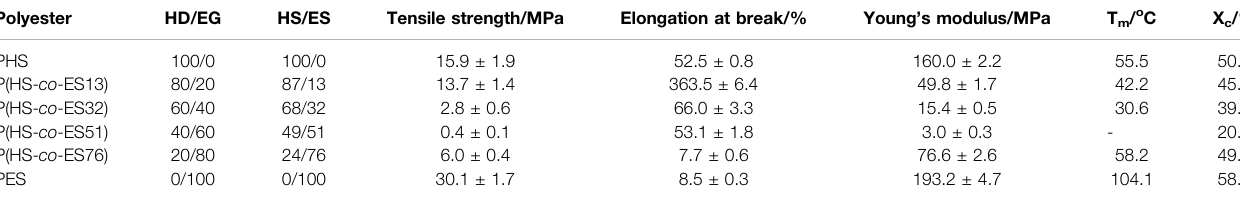
TABLE 1 | Composition and mechanical and thermal properties of P(HS- co -ES) copolyesters. Polyester